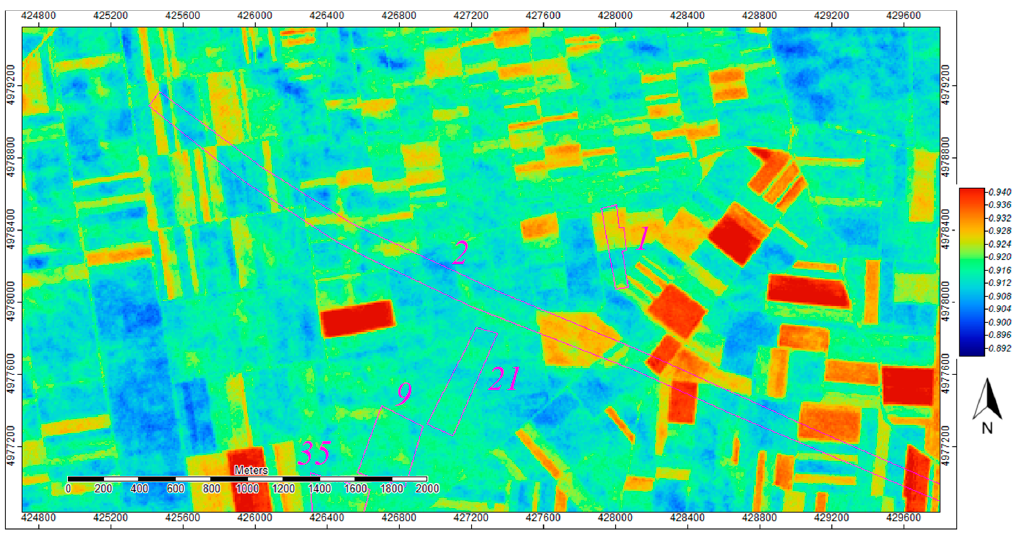
Figure 5. Output details of CC3 algorithm application to the Sentinel-2 image. The areas including the Roman road and other buried archaeological remains are marked in magenta, but it was not possible to detect them through this image. For a geographical reference, see the crop-marks identification numbers and locations in Figure 9.